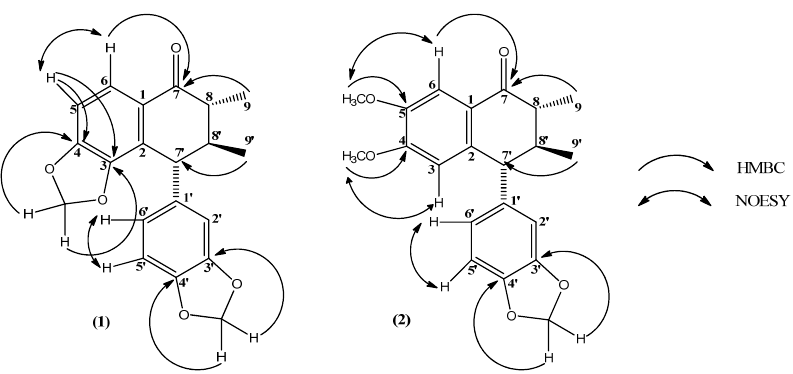
Figure 1. Main HMBC and NOESY interactions for compounds 1 and 2